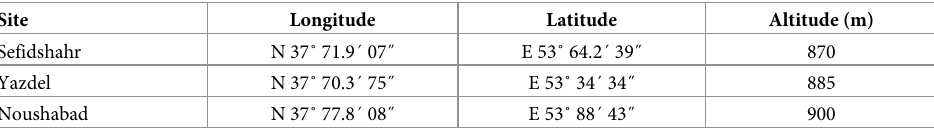
Table 1. Geographical characteristics of the studied crop sites in the Kashan